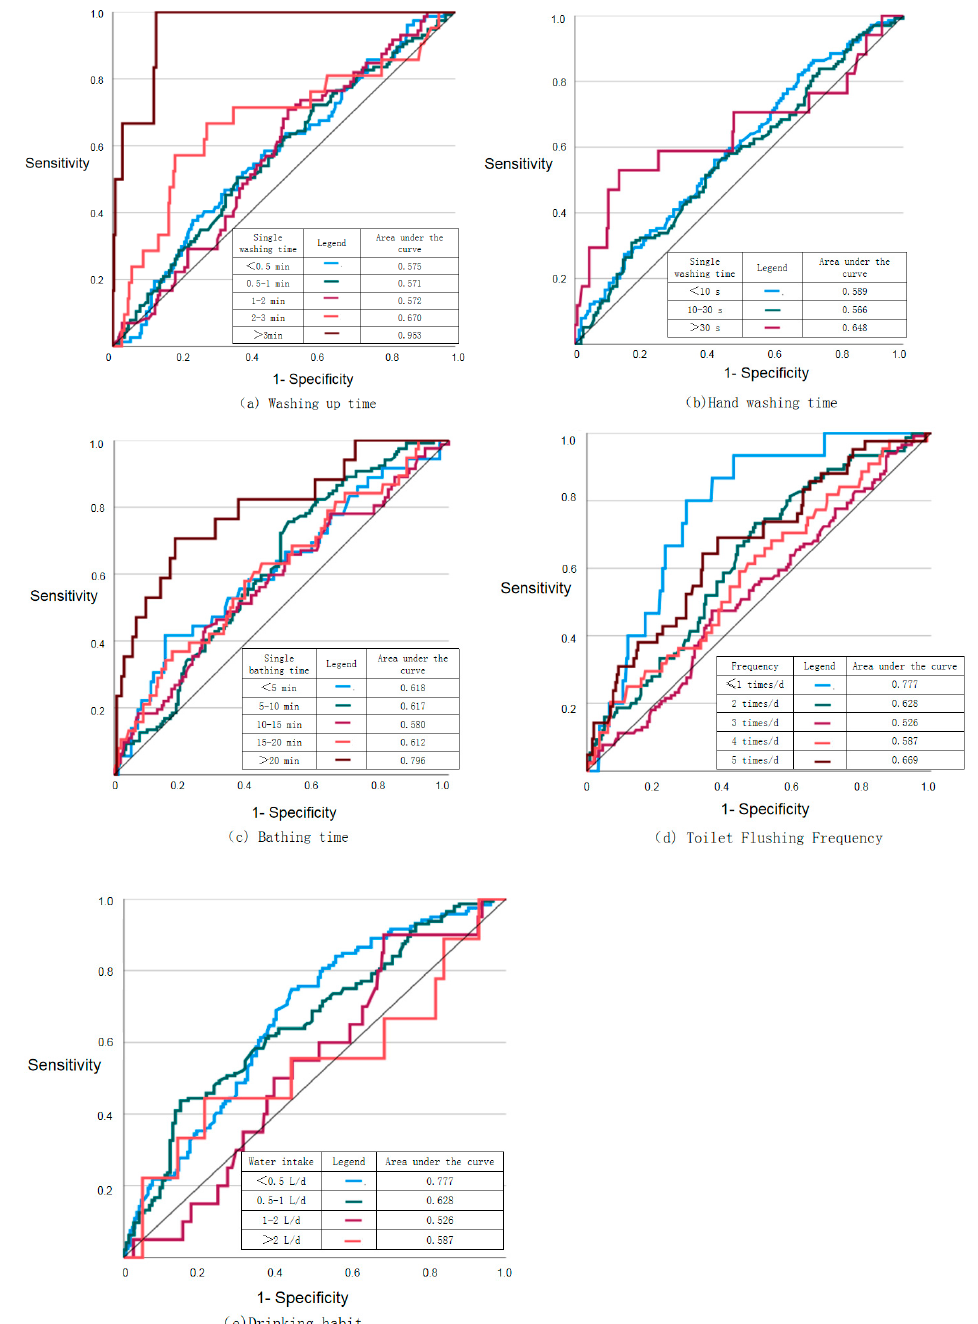
Figure 4. Receiver Operating Characteristic ( ROC) curve of the MLP neural network model for the water-use behavior of hotel consumers: ( a ) Washing-up time; ( b ) Hand-washing time; ( c ) Bathing time; ( d ) Toilet-Flushing Frequency; and ( e ) Drinking habit.